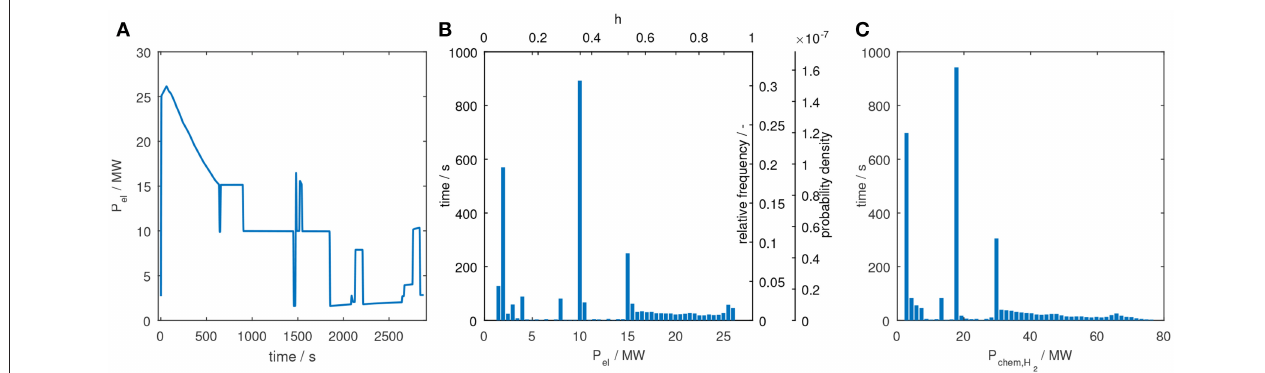
FIGURE 3 | Transformation of a single mission profile of an Airbus A320 short-range flight (A) into the corresponding electric power histogram (B) , and by including the fuel cell efficiency into the histogram of the required chemical power of hydrogen (C)